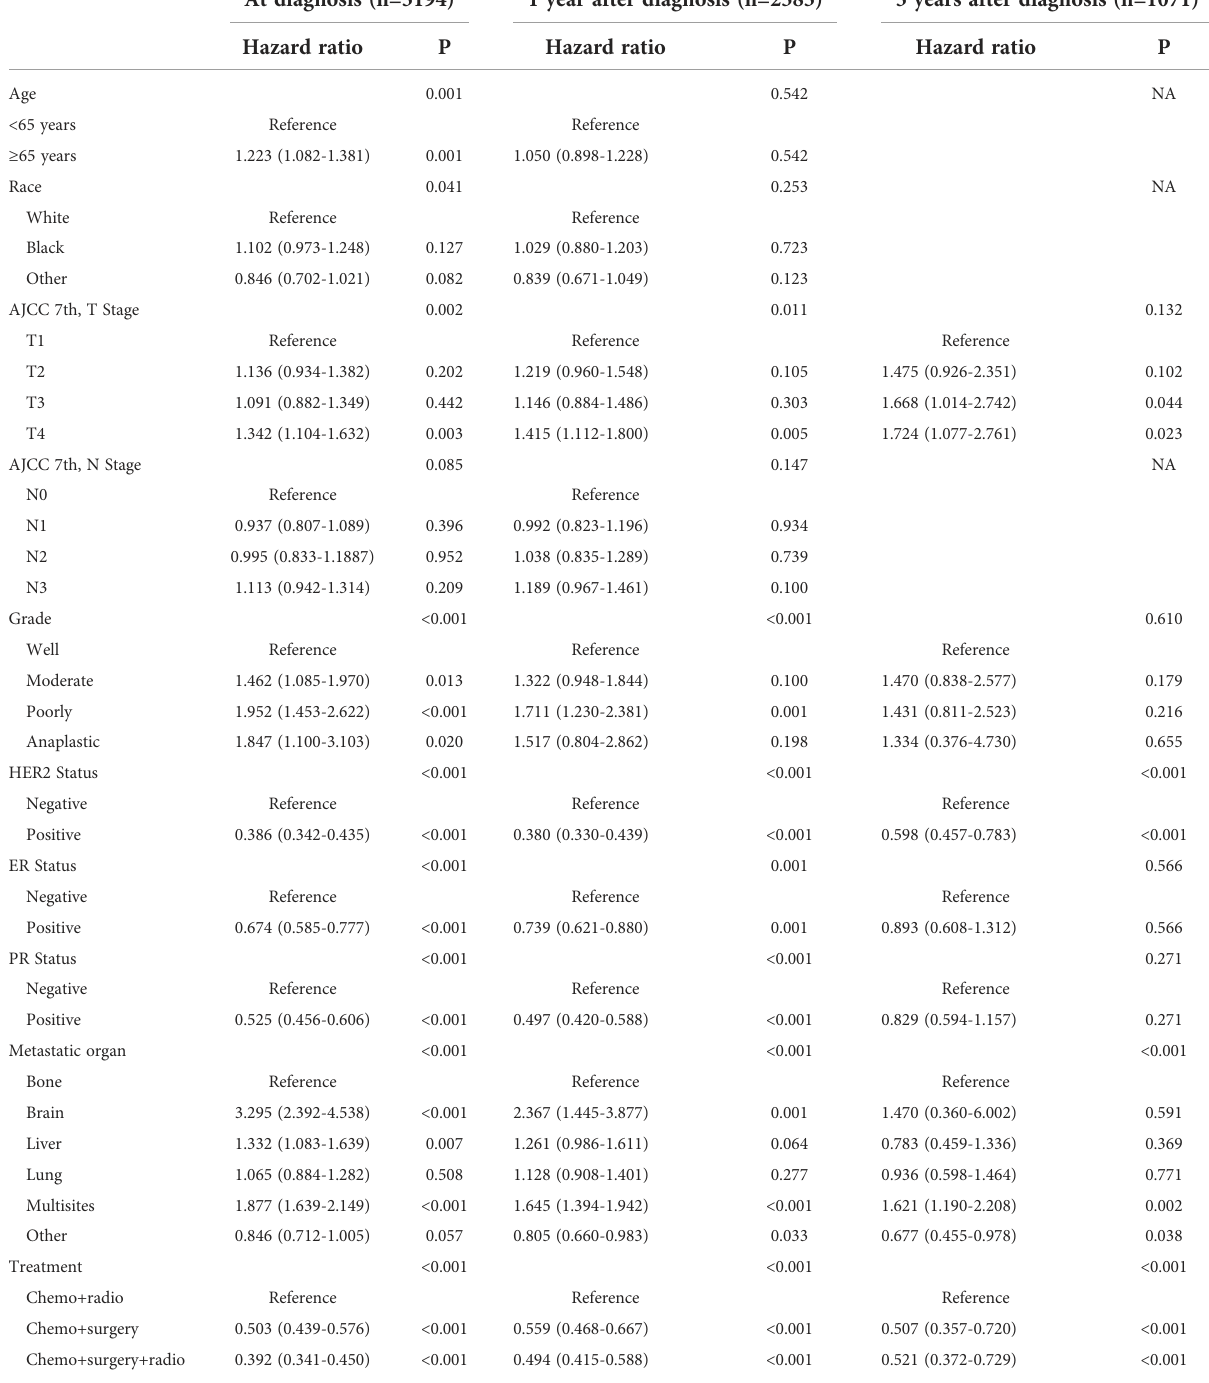
TABLE 3 Multivariable Cox proportional hazards analysis of risk factors associated with cause-speci fi c